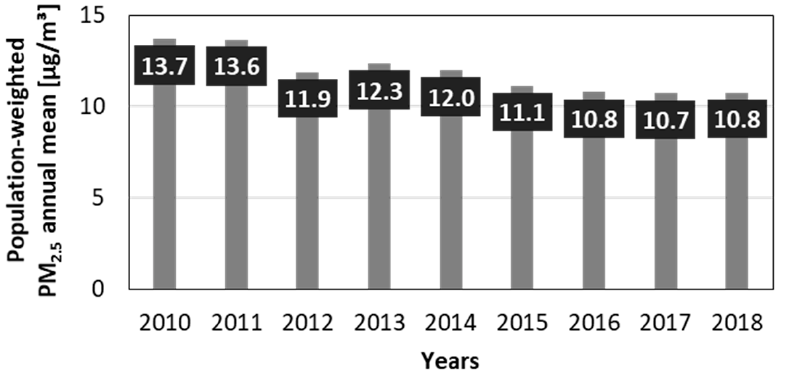
Figure 2. Nationwide population-weighted PM 2.5 annual mean exposure from 2010 to 2018 in Ger- many.